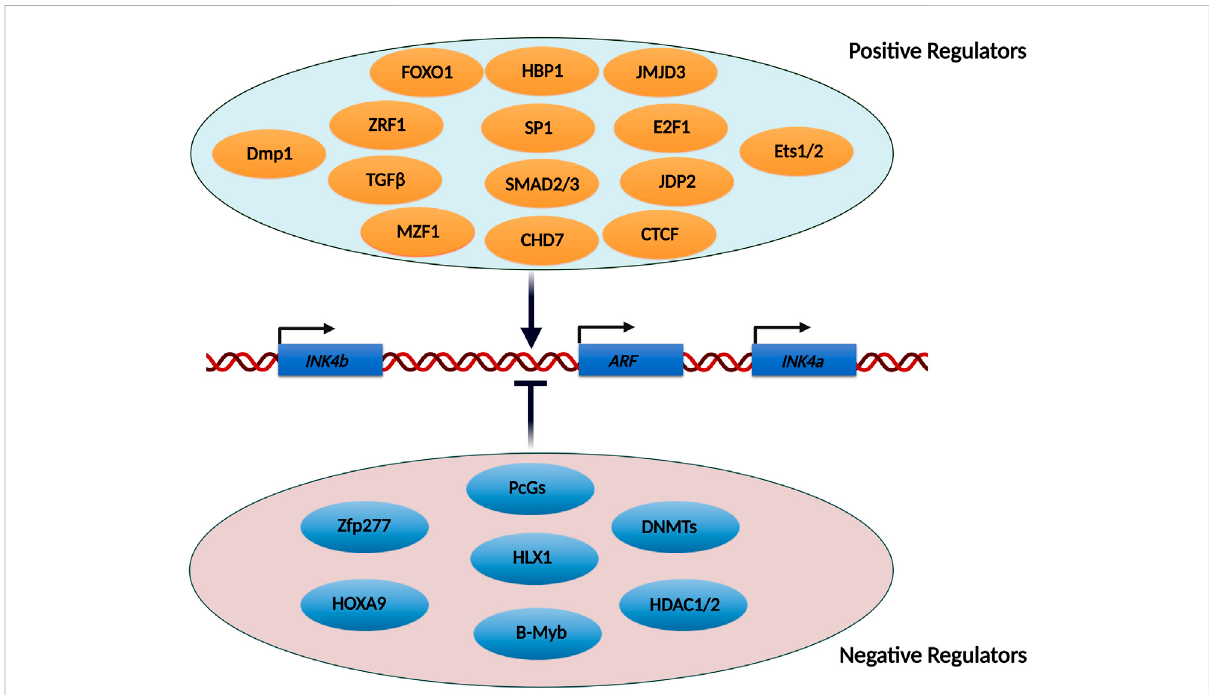
FIGURE 3 List of transcription factors and epigenetic modi fi ers known to regulate the INK4/ARF locus. The INK4/ARF locus is regulated by a number of transcription factors and epigenetic modi fi ers. Some of the factors stimulate transcription from this locus, whereas others repress it. Some of these factors act directly on the promoters, facilitating the binding of RNA polymerase, while others activate enhancers located upstream of the